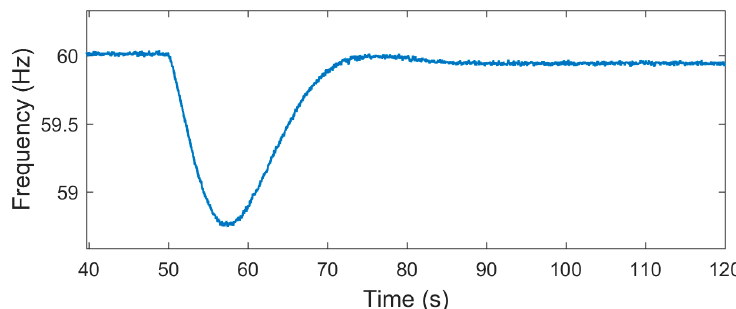
Figure 7. Grid frequency of the event without wind turbine participation.